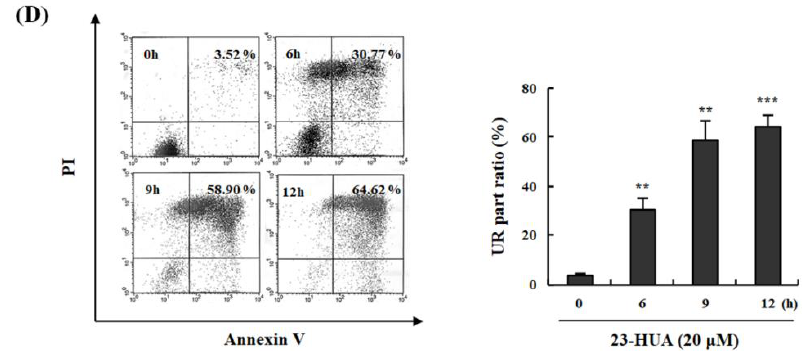
Figure 1. Induction of apoptosis in 23-HUA-treated HL-60 cells. ( A ) Chemical structure of 23-hydroxyursolic acid (23-HUA). ( B ) Percentages of DNA fragmentation was determined by fluorometric analysis using DAPI. ( C ) Fragmented DNA of HL-60 cells treated with 20 µM 23-HUA for 0, 3, 6, 9 and 12 h detected using 2% agarose gel after visualization with ethidium bromide stain. HL-60 cells treated with 50 µM cisplatin (Cis) were used as positive control. ( D ) Cells were co-stained with PI and FITC-conjugated annexin V after treatment with 20 µM 23-HUA to detect externalization of phosphatidylserine (PS) followed by flow cytometric analysis. Data are means ± S.D. of triplicate experiments. * p < 0.05, ** p < 0.01 and *** p < 0.001 vs. control group.